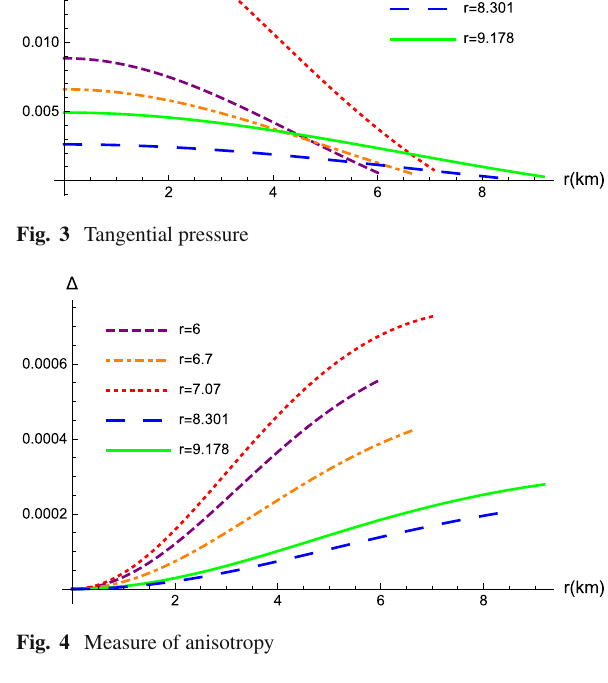
Fig. 3 Tangential pressure